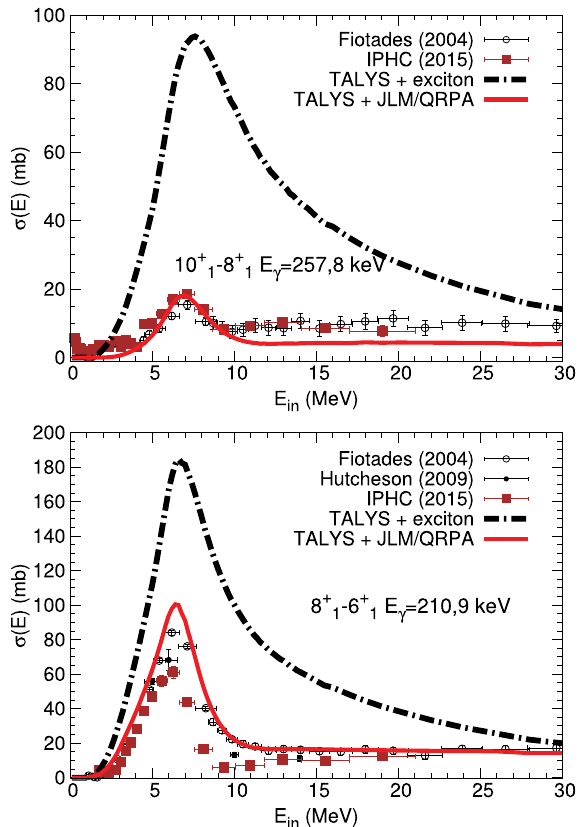
Fig. 5. 238 U( n , n 0 g ) cross-sections for two transitions in the ground state rotational band (see details on plots). Two Talys calculations, which used the exciton (dashed black curves) or the JLM/QRPA model (full red curves) for pre-equilibrium, are compared to experimental data (symbols) [18 – 20].